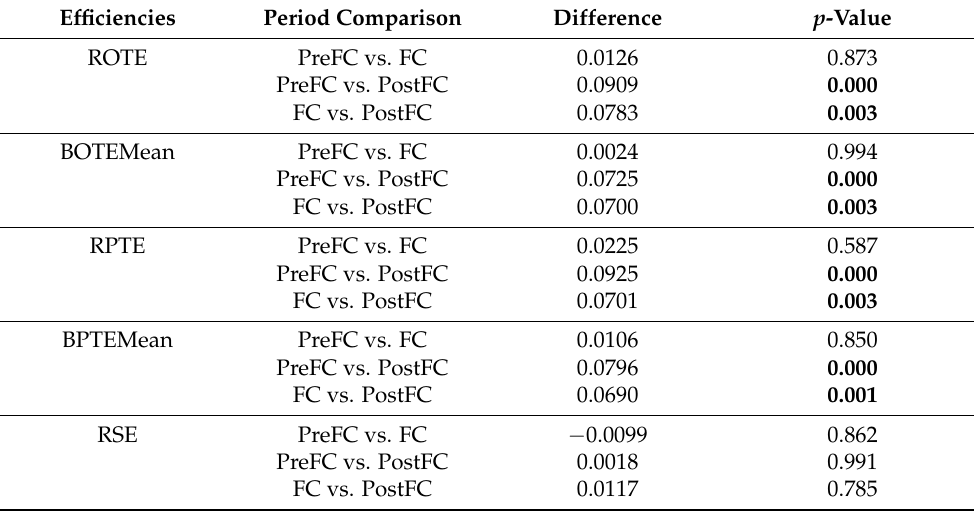
Table 7. Results of Tukey’s multiple comparisons of the means of the efficiencies for the periods PreFC, FC, and